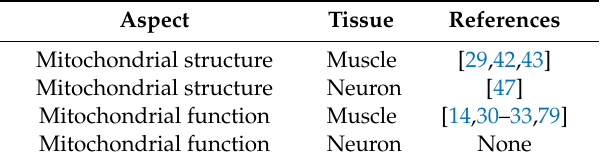
Table 1. Mitochondrial structure and function changes with aging.